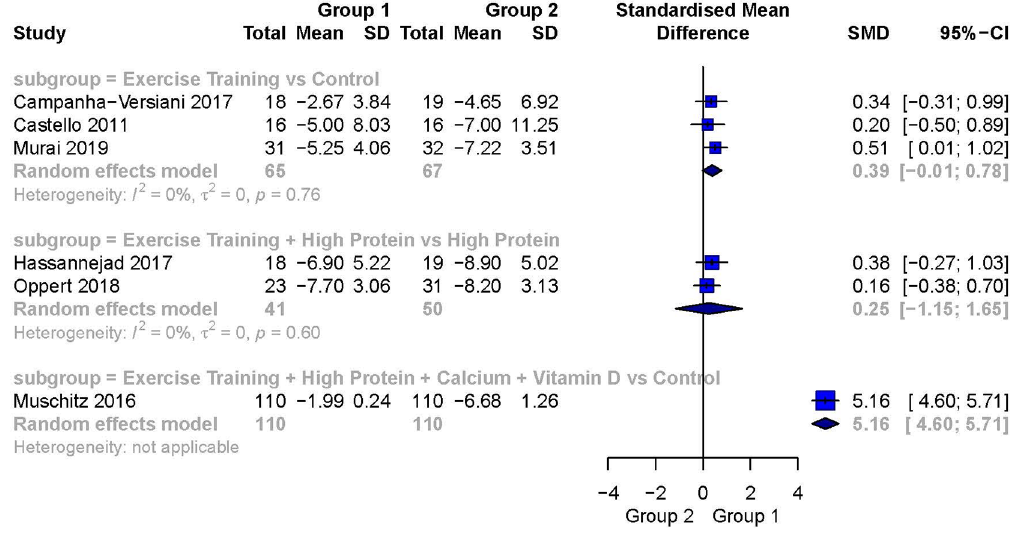
Figure 6. Forest plot of the meta-analysis of outcome change scores for fat-free mass (kg) during surgery- induced weight loss.